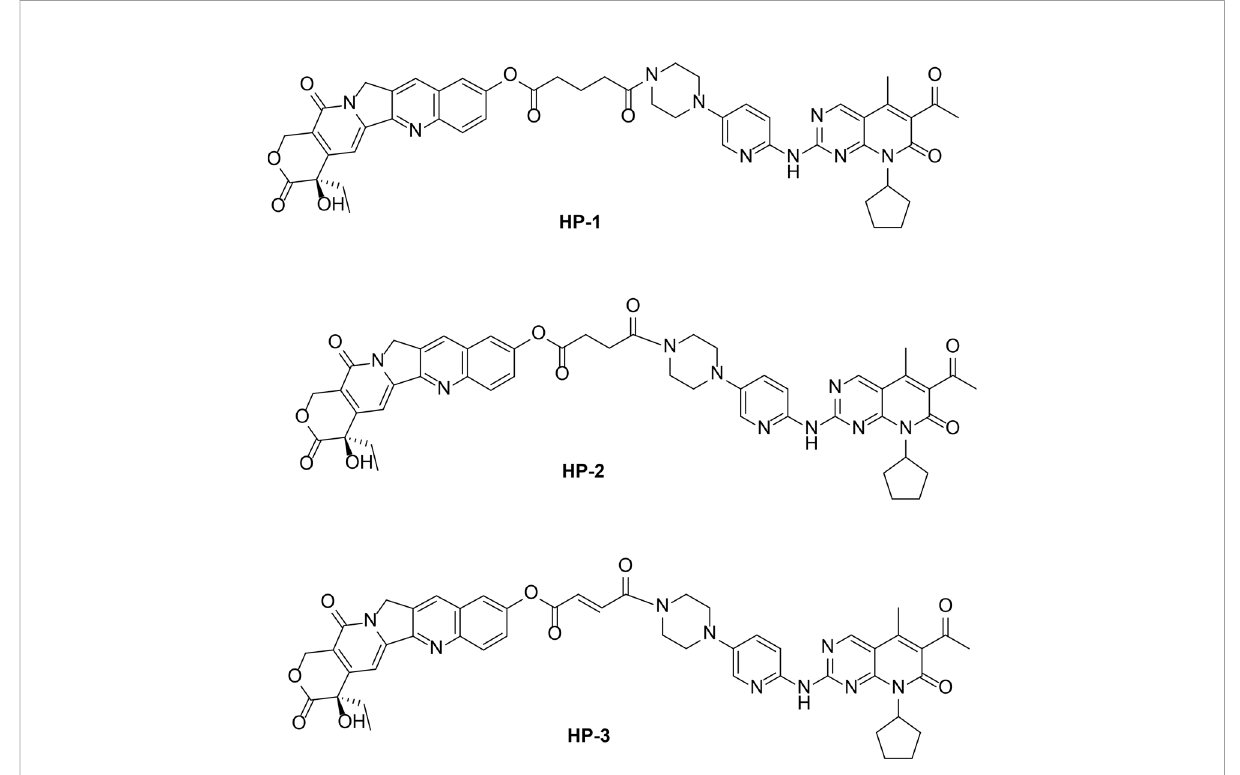
FIGURE 2 Chemical structures of HP-1 , HP-2 , and HP-3